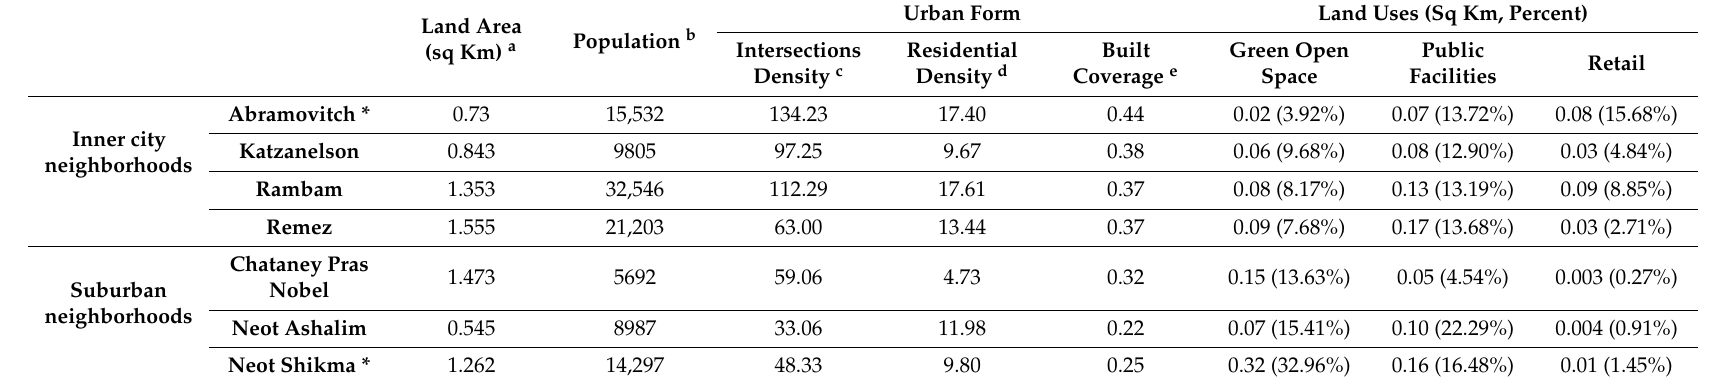
Table 1. Neighborhood-level descriptive statistics of Geographical Information System (GIS)-based environmental